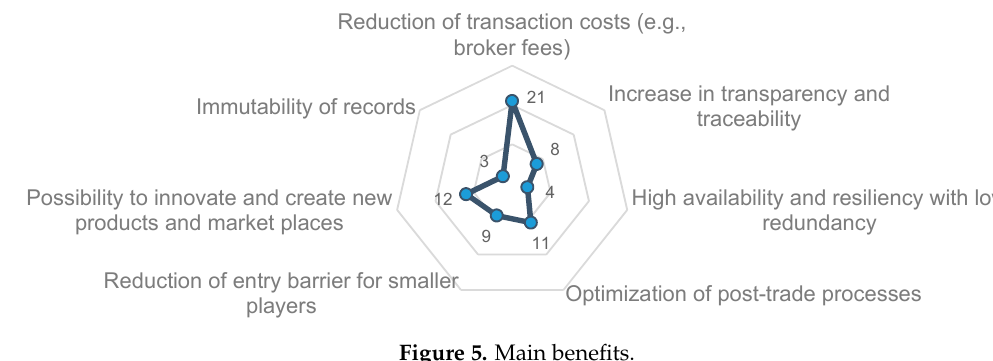
Figure 5. Main Figure 5. Main benefits.